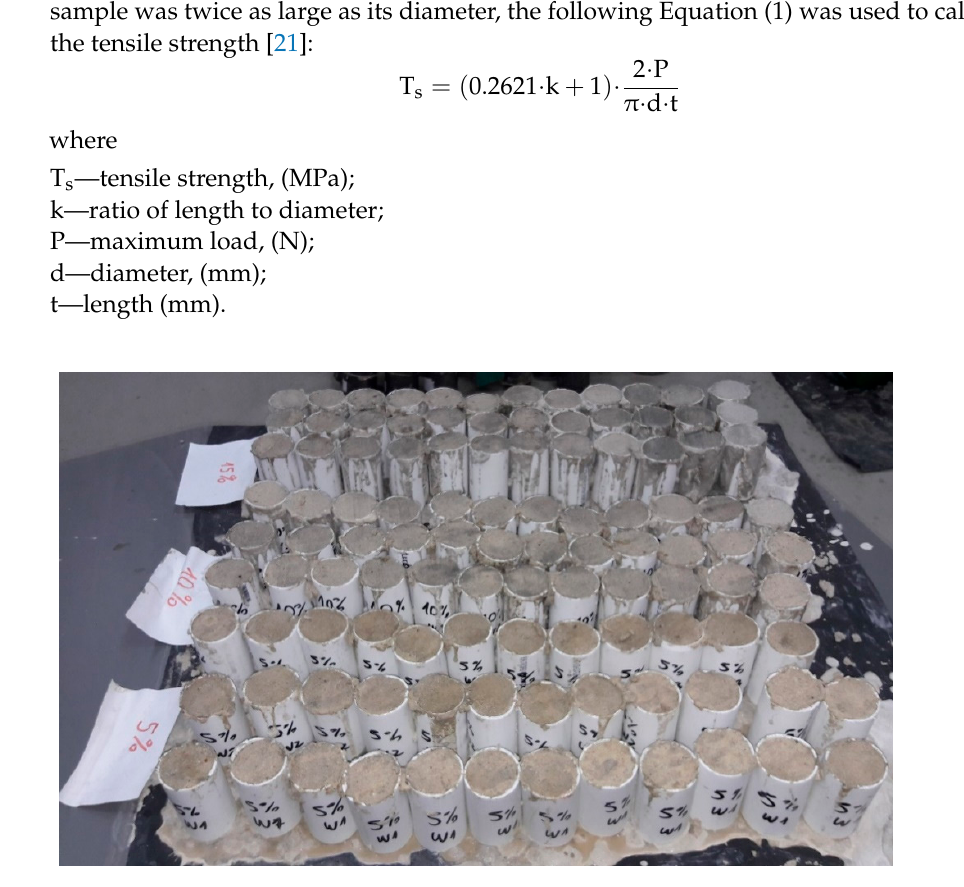
Figure 5. Regular samples filled with a backfill mixture with different cement contents.